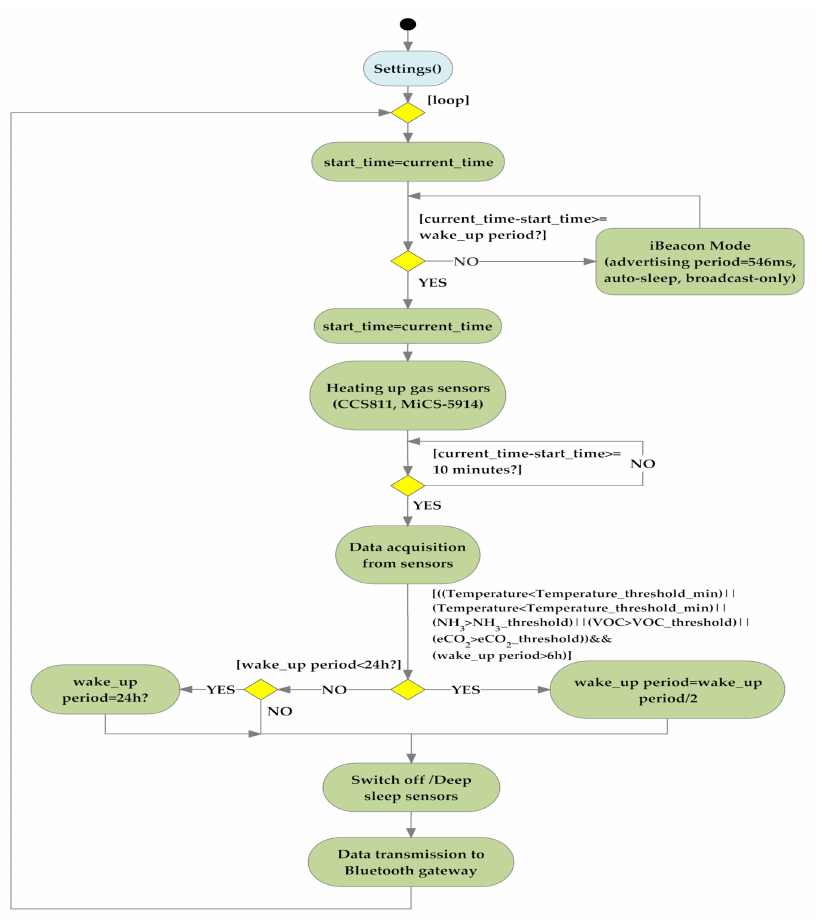
Figure 16. Flowchart related to the operation modality of developed Bluetooth low energy (BLE) smart tag placed inside the container where the agri-food products are